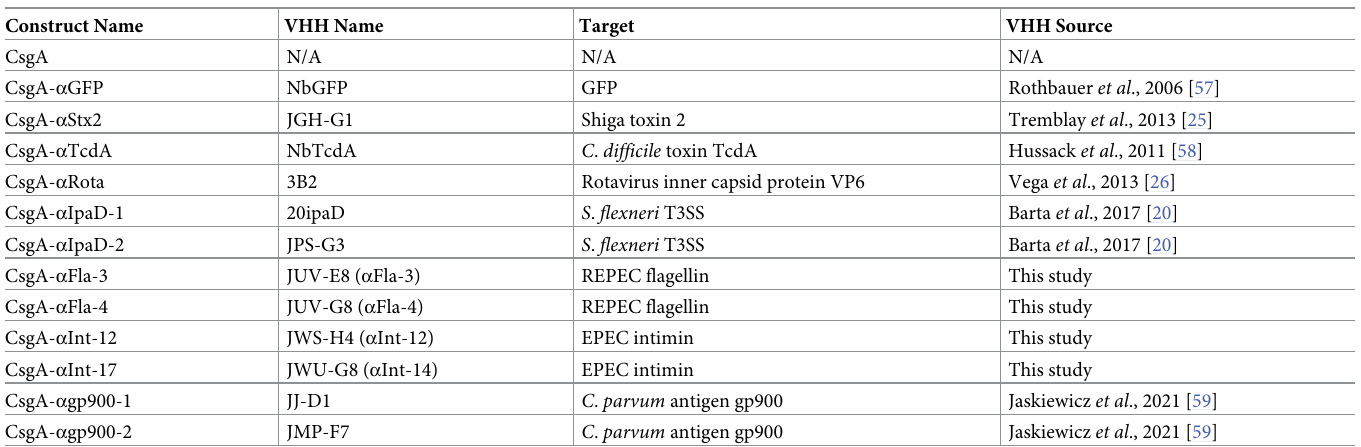
Table 2. CsgA-VHH